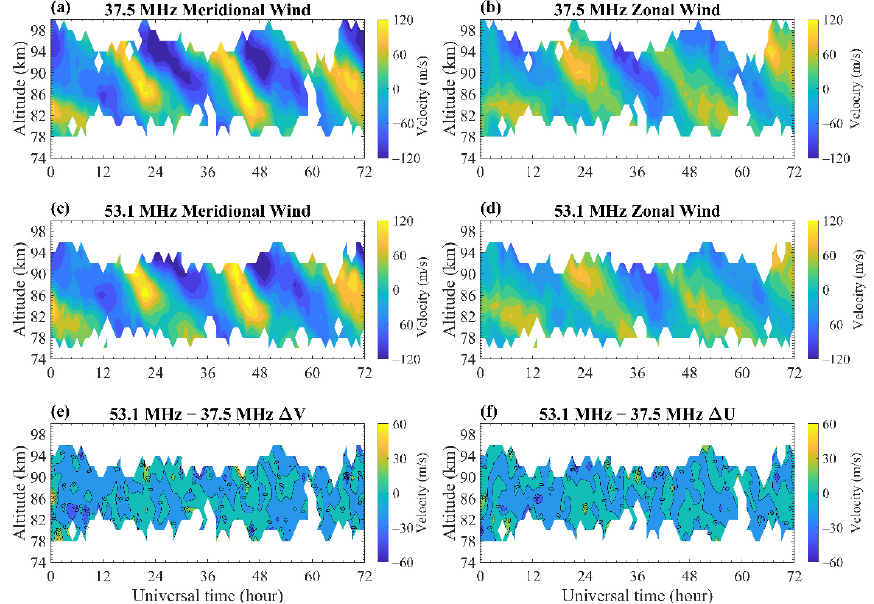
Figure 7. Comparisons between the hourly zonal and meridional winds from 8 to 10 November 2013, observed by the ( a , b ) 37.5 MHz MR and ( c , d ) 53.1 MHz MR. ( e , f ) Wind difference between the 53.1 MHz and 37.5 MHz MRs. Same as Figure 2 but for the winds after the azimuth reference direction has been corrected. direction has been